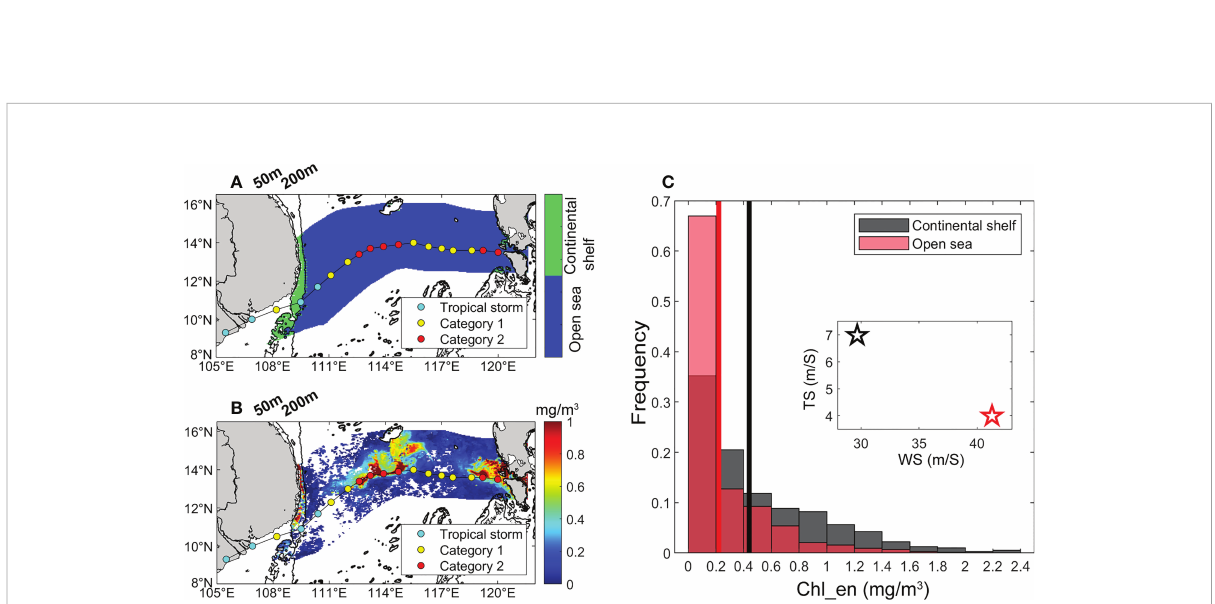
FIGURE 8 (A) TC Durian in fl uenced area in the continental shelf (green shading) and open sea (blue shading) region. The black contour represents the 50-m and 200-m isobaths; (B) composite Chl_en plot; (C) Frequency histogram of the proportion of grids with different Chl_en to total non-empty grids of the TC-in fl uenced area in the continental shelf (black bar) and open sea (red bar) region. The black and red lines represent the average Chl_en in the two regions. The black and red pentacles represent the average wind speed and translation speed of TC Durian in the two regions.